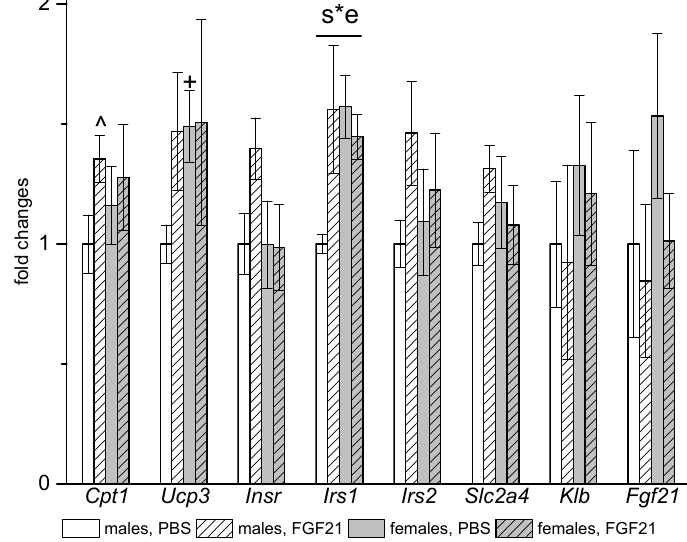
Figure 7. Influence of FGF21 administration on muscle gene expression in obese A y male and female mice. Data are presented as mean ± SE. Mice were administered FGF21 for 7 days. Significant influence ( p < 0.05) of the interaction of factors “e” (administration of PBS or FGF21) and “s” (sex) “s*e” two-way ANOVA is indicated in the plot. In the hypothalamus, sex differences were observed in the expression of the orexin gene Hcrt, which was higher in males regardless of FGF21 treatment. FGF21 administration had no effect on the expression of the studied genes, with the exception of the gene for leptin receptor (Figure 8). FGF21 administration increased the level of Lepr mRNA in males and decreased it in females.